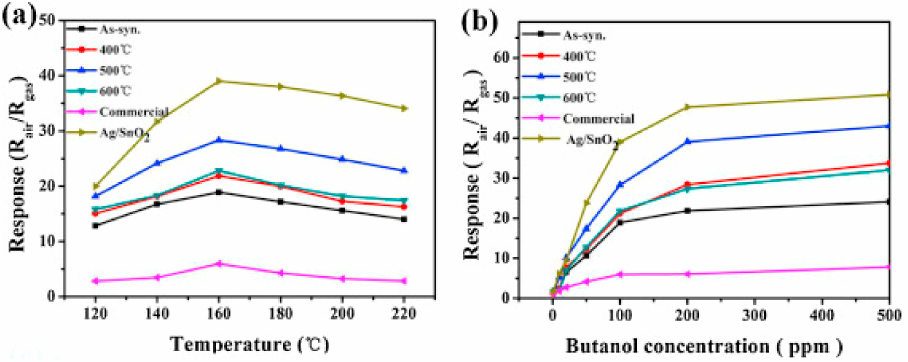
Figure 26. A comparison between sensor response SnO 2 NPs: ( a ) 100 ppm butanol at various working temperatures; ( b ) response of sensor at 160 ◦ C towards various concentrations of butanol (5–500 ppm). Reprinted from Ref. [220] with permission of Elsevier B.V.,